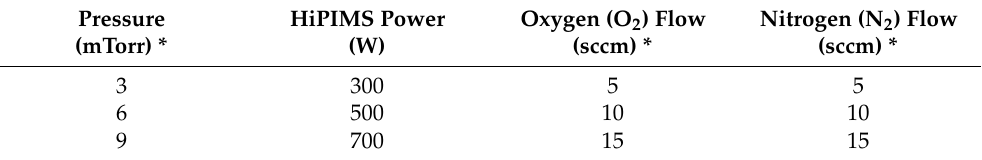
Table 1. The values of the HiPIMS reactive magnetron sputtering process selected for optimizing the electrical properties of HfO x N y films. Pressure HiPIMS (mTorr) *